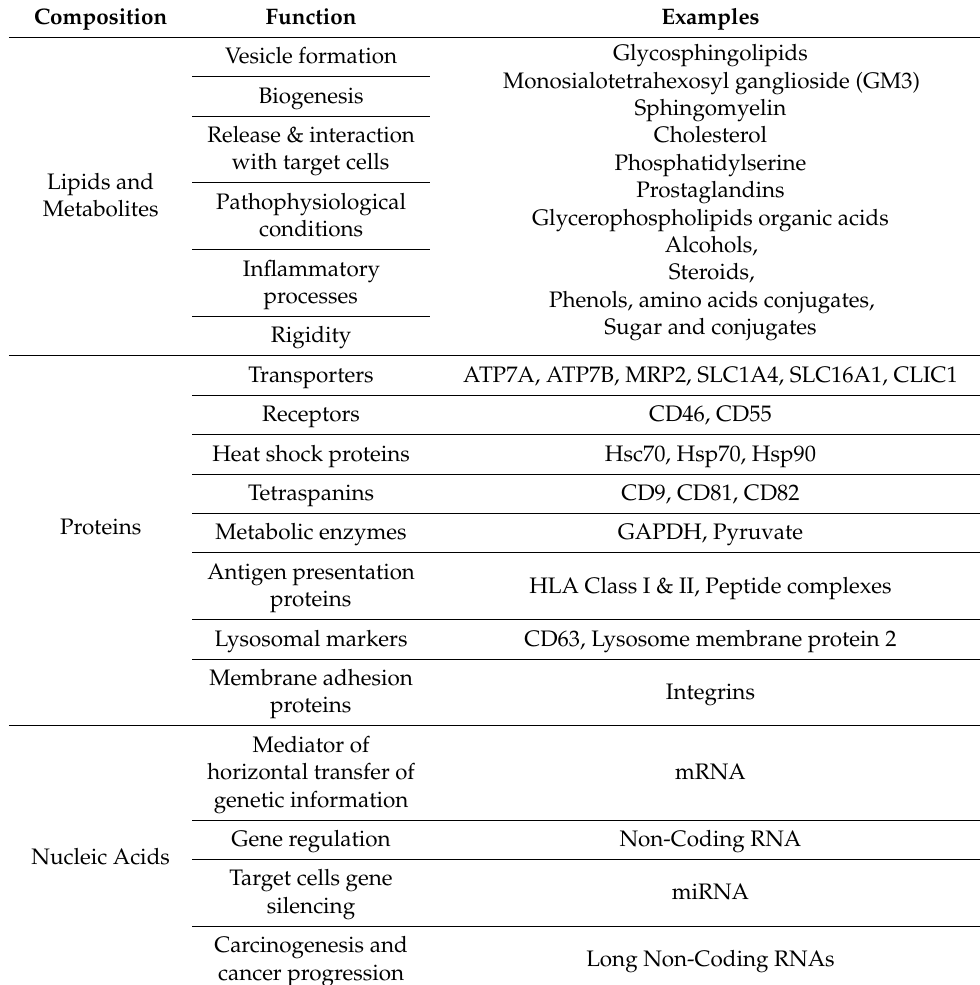
Table 1. Composition of exosomes, functions of components and examples; adapted with kind permission from reference